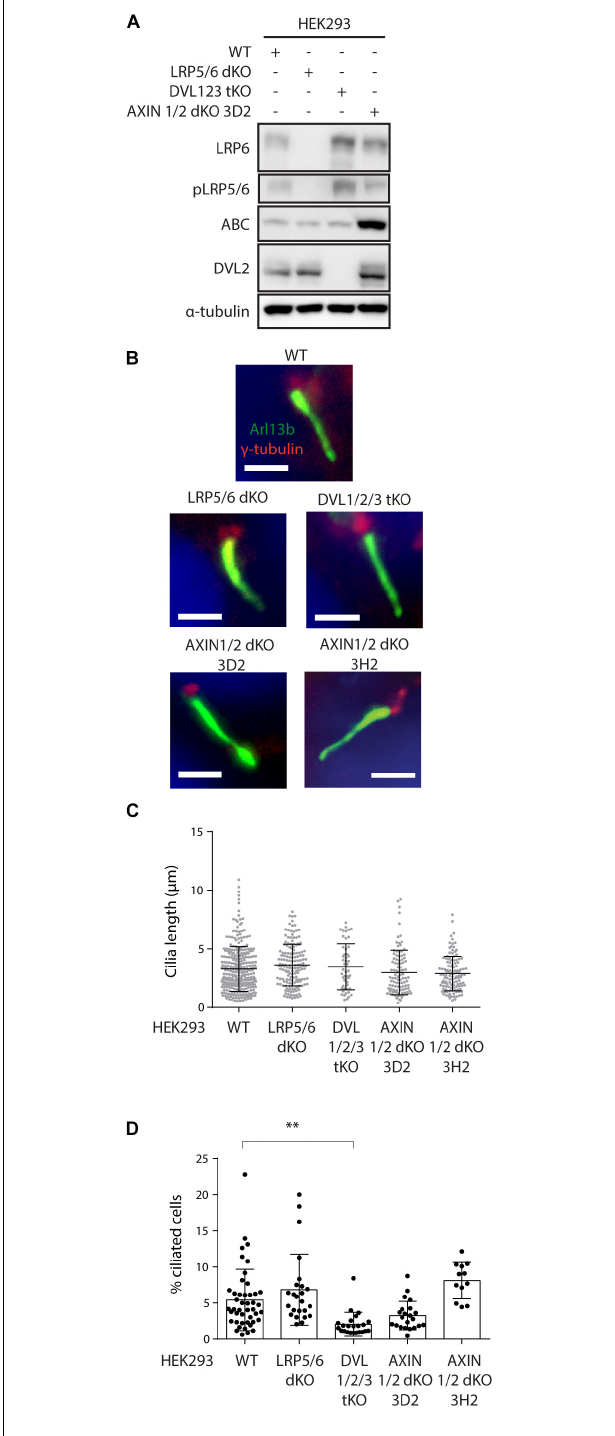
FIGURE 3 | Ablation of WNT β -catenin pathway does not alter primary ciliogenesis. (A) Western blot analysis of individual HEK293 KO cell lines using the indicated antibodies. Note that LRP5/6 dKO cells lack LRP6 and phospho LRP5/6 (pSer1493/pSer1490), DVL1/2/3 tKO cell do not have detectable levels of DVL2. AXIN1/2 dKO cells shown elevated level of ABC. (B–D) HEK293 Cells were starved for 48 h, stained for Arl13b (green), γ -tubulin